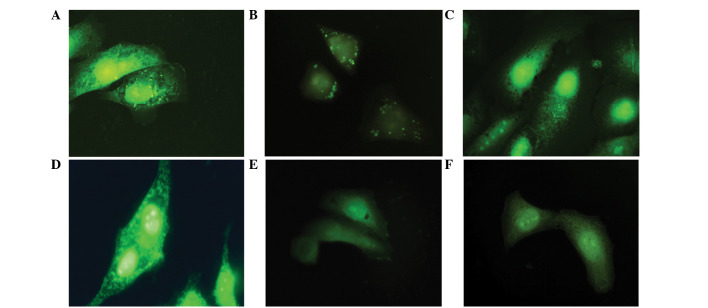
Immunostaining demonstrating β1-integrin and FAK expression in HEp-2 cells 12 h following PDT. The expression of β1-integrin in (A) the control group, cells with labeled in border (arrow); (B) the AlPcS4/PDT group, cells with diffuse labeling in the cytoplasm (arrow); (C) the ZnPc/PDT group, cells with some diffuse labeling in cytoplasm (arrow). FAC expression in (D) the control group, with numerous focal adhesion points (arrow); (E and F) the AlPcS4/PDT and ZnPc/PDT groups, where focal adhesion was not observed. PDT, photodynamic therapy; AlPcS4, aluminum phthalocyanine tetrasulfonated; ZnPc, zinc phthalocyanine; FAK, focal adhesion kinase.